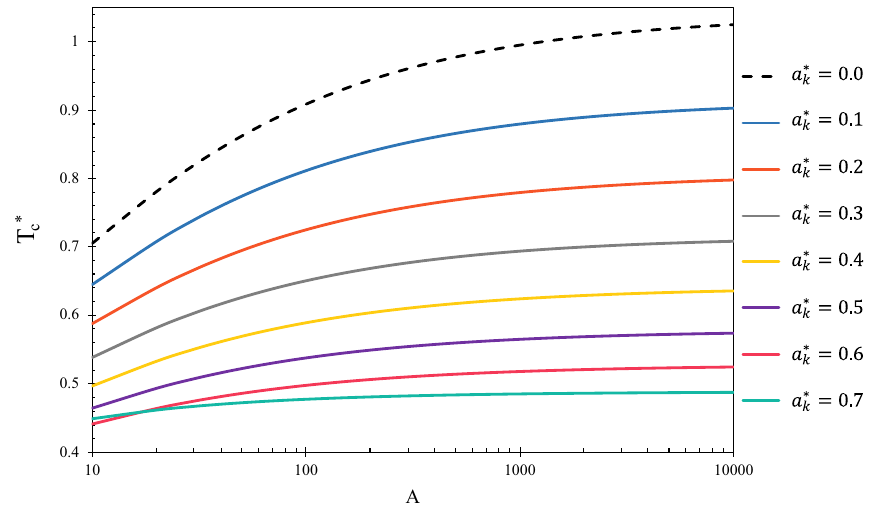
Figure 6. Value of T ∗ c versus pore size for different values of a ∗ k (different fluids).